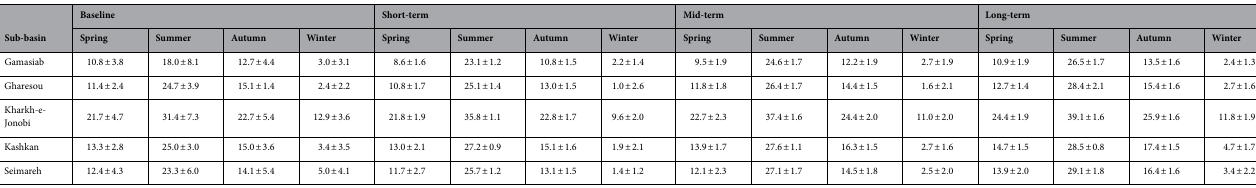
Table 1. The average surface air temperature in all sub-basins under baseline and climate change conditions (°C). The recorded values are within a 95% confidence interval.